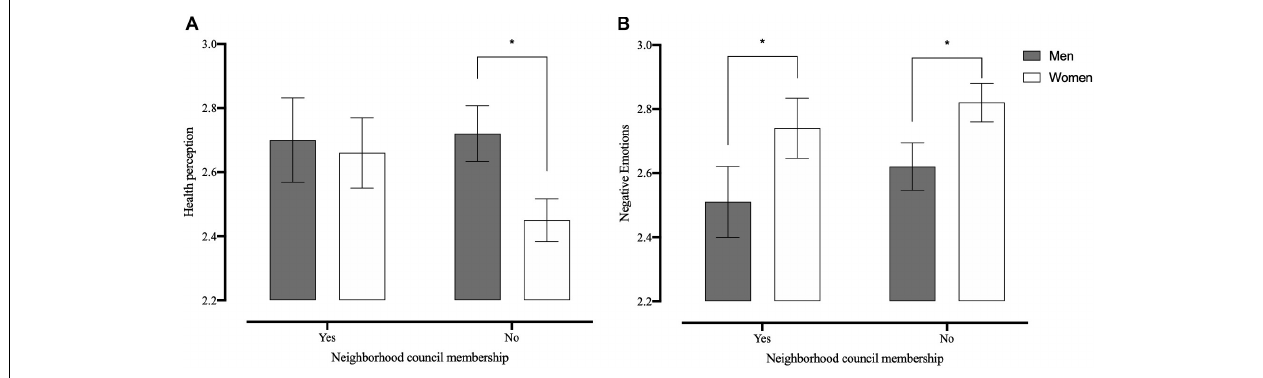
FIGURE 1 | Comparison of perceived health (A) and negative emotions (B) scores in older adults by sex and neighborhood council membership. *Differences between groups are statistically significant ( p < 0.05).